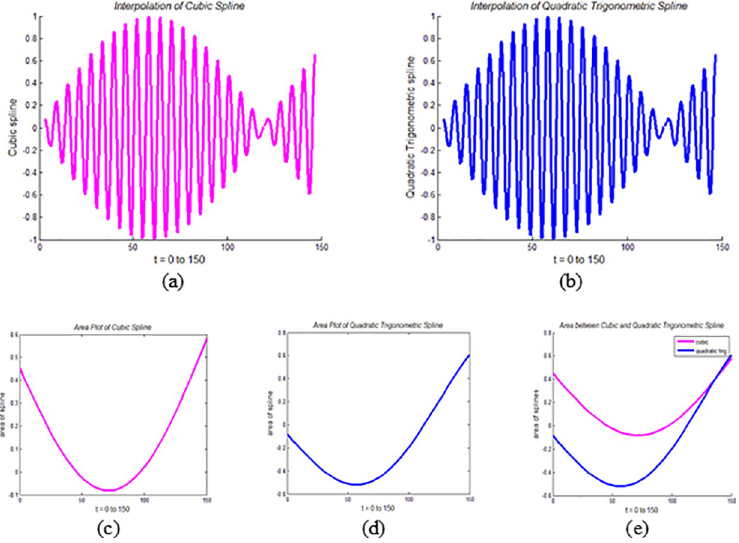
Fig 5. Area Analysis of QTS and CPS using f = sin( t ): (a) Plot of CPS, (b) Plot of QTS, (c) Area plot of CPS, (d) Area plot of QTS, and (e) Area between CPS and